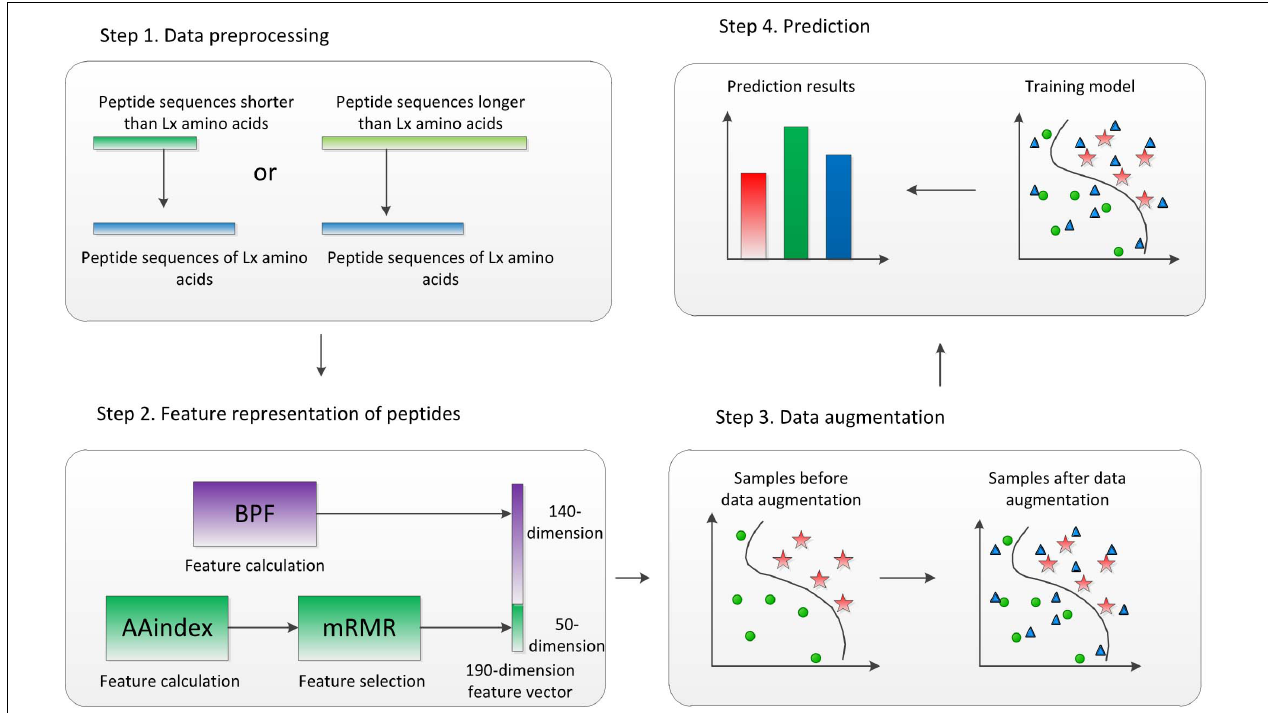
FIGURE 1 | Flowchart of ACP-DA. Binary profile features (BPFs) and AAindex features after feature selection were concatenated to represent peptides, and the samples in the training set were augmented in the feature space. The samples after data augmentation were used to train the multilayer perception (MLP) model, which was used for the prediction of anticancer peptides